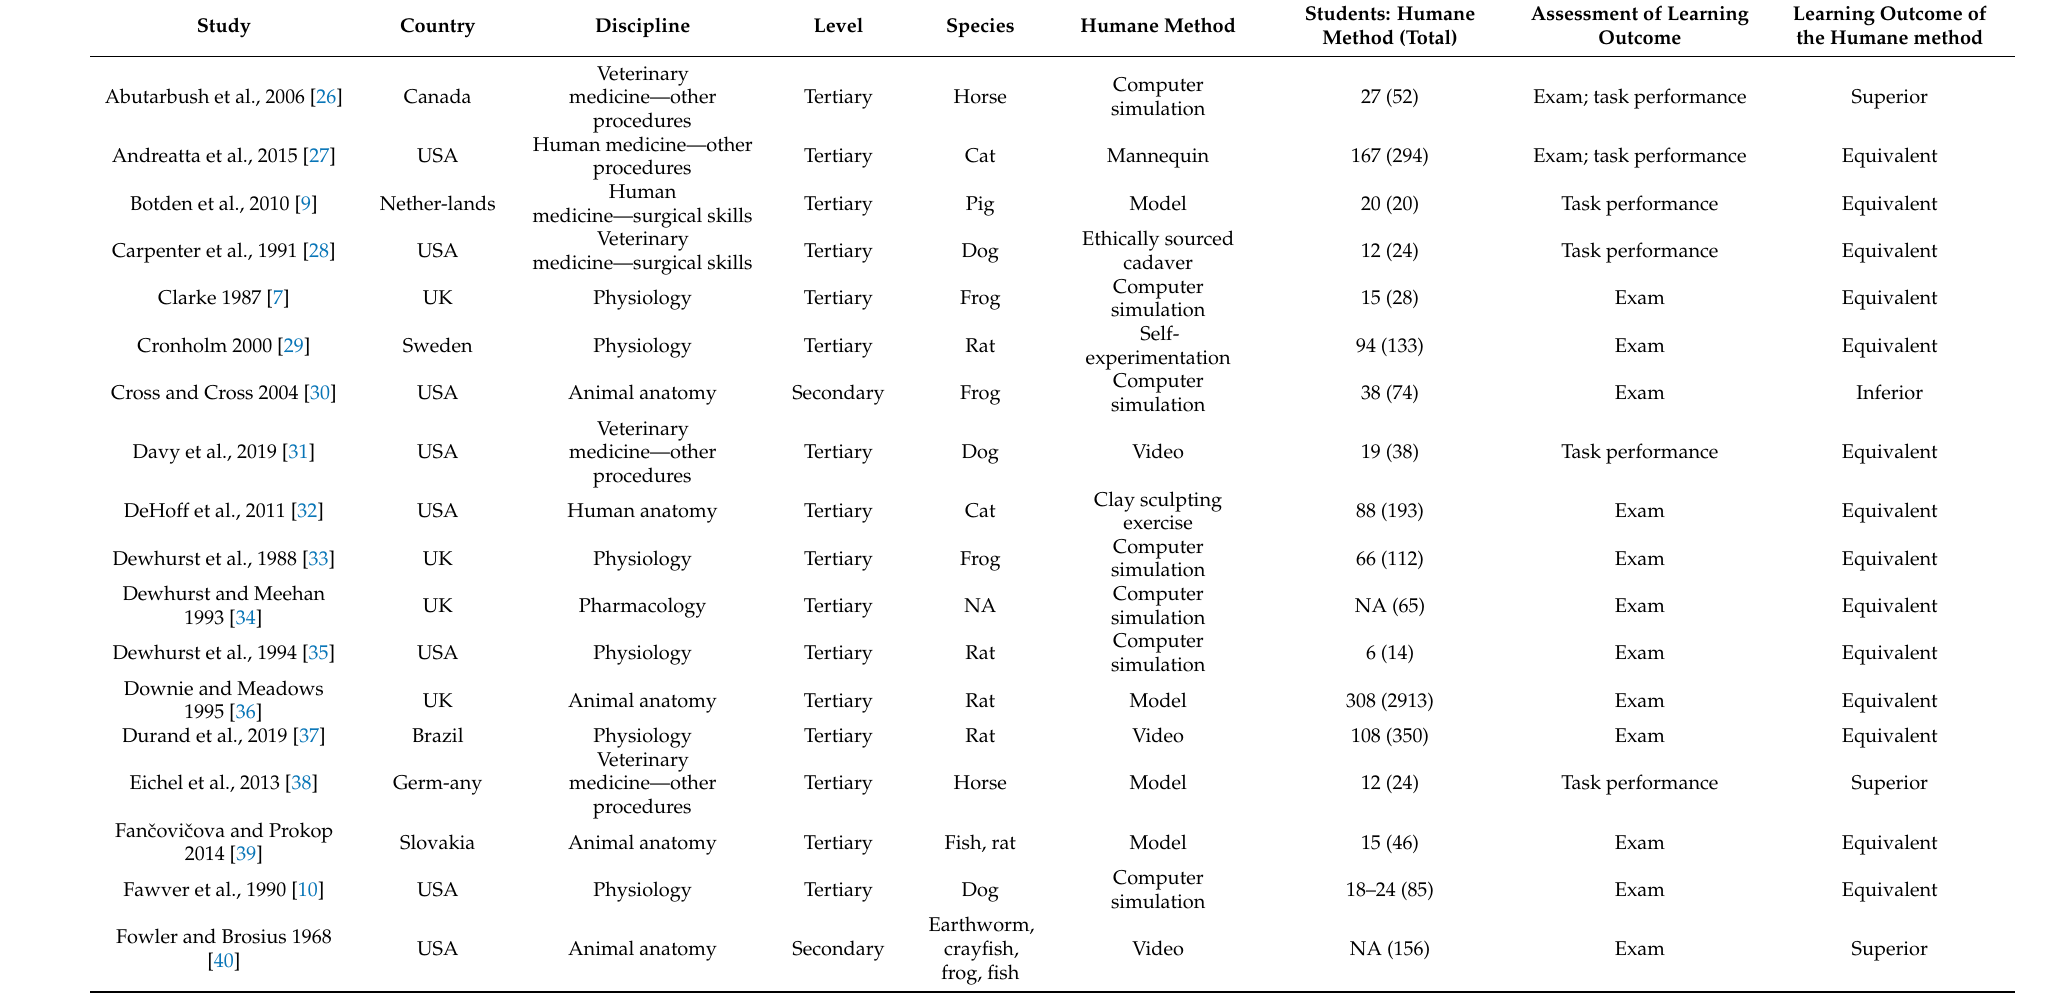
Table 1. Relevant studies identified in the systematic review, comparing the learning outcome of a humane teaching method with harmful animal